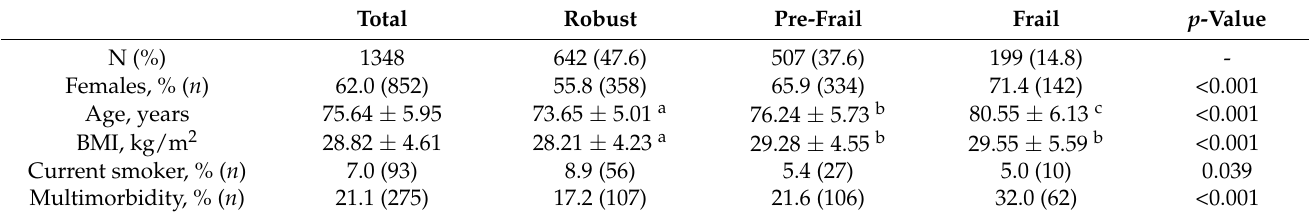
Table 1. Participant characteristics.